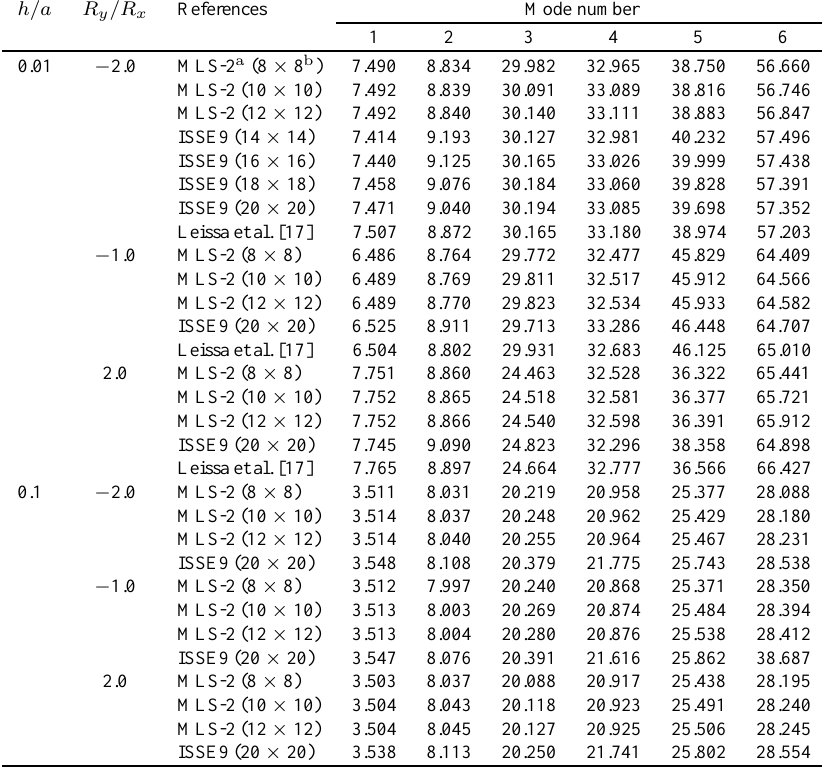
(cid:1) Table 1 ( ρh ) /D ) of an isotropic doubly curved shell panel (Fig. 2) clamped